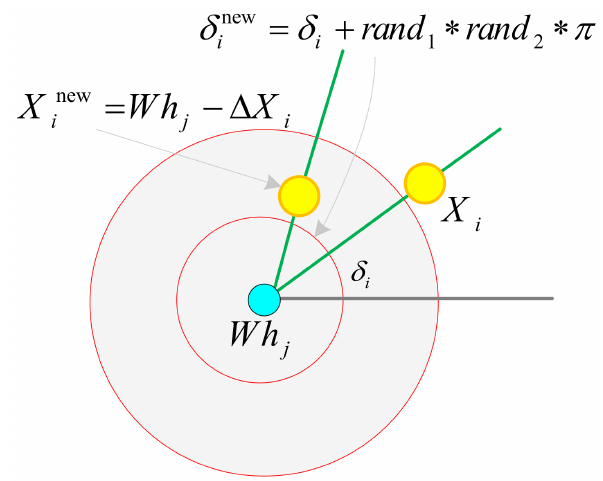
Figure 1. The model by whirlpool for optimization